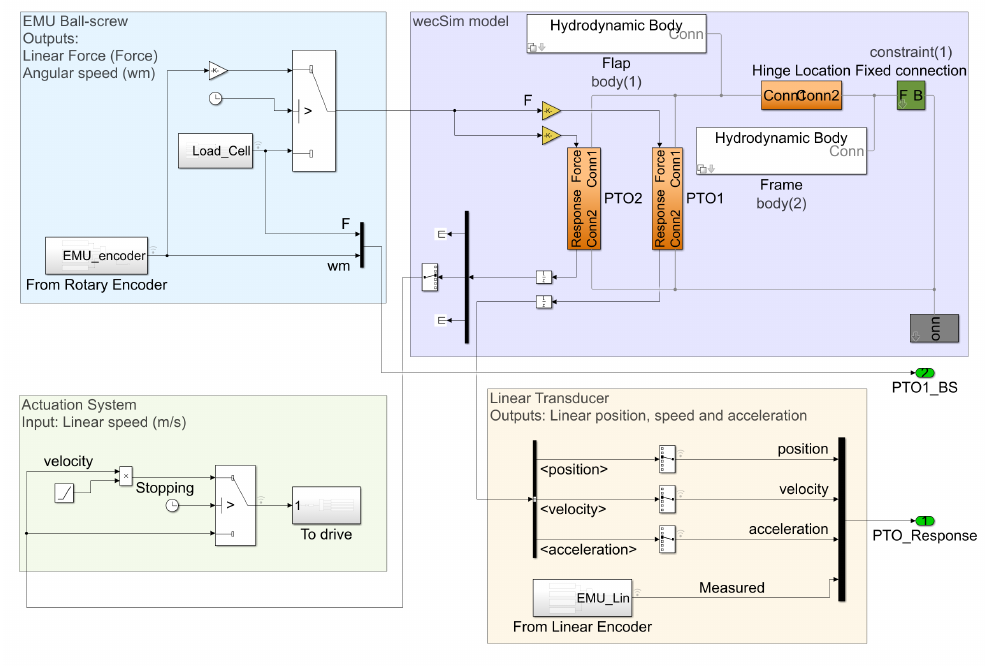
Figure 8. Matlab/Simulink Model for HIL tests including the WEC and interfaces with the test